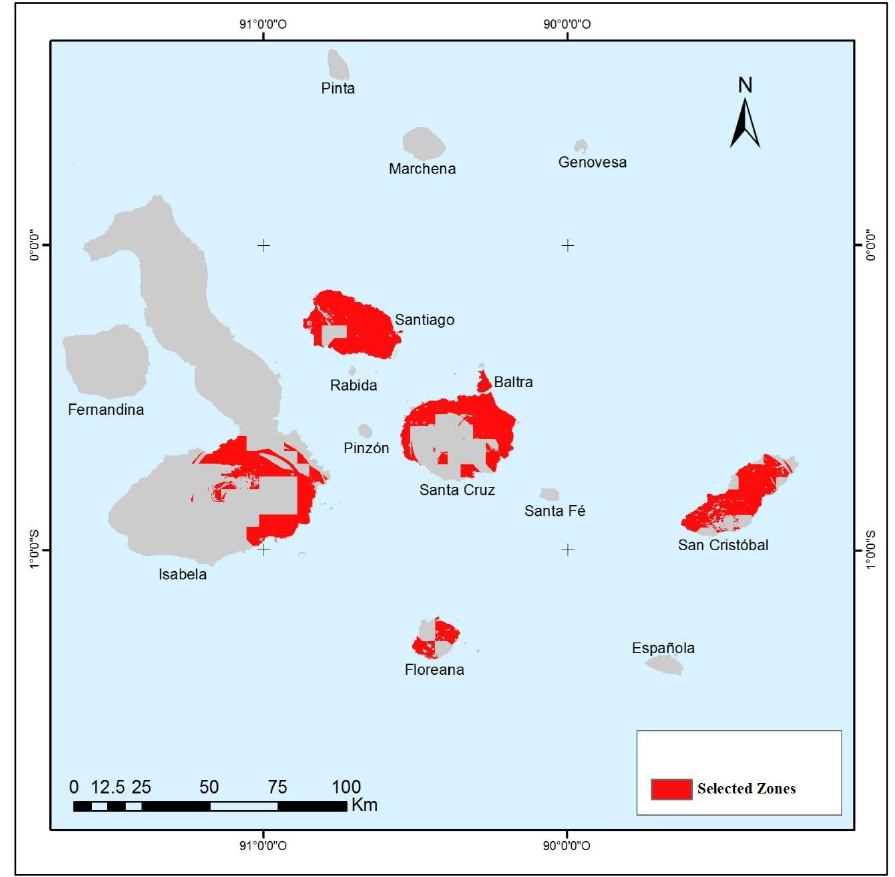
Figure 7. Suitable locations for photovoltaic projects.